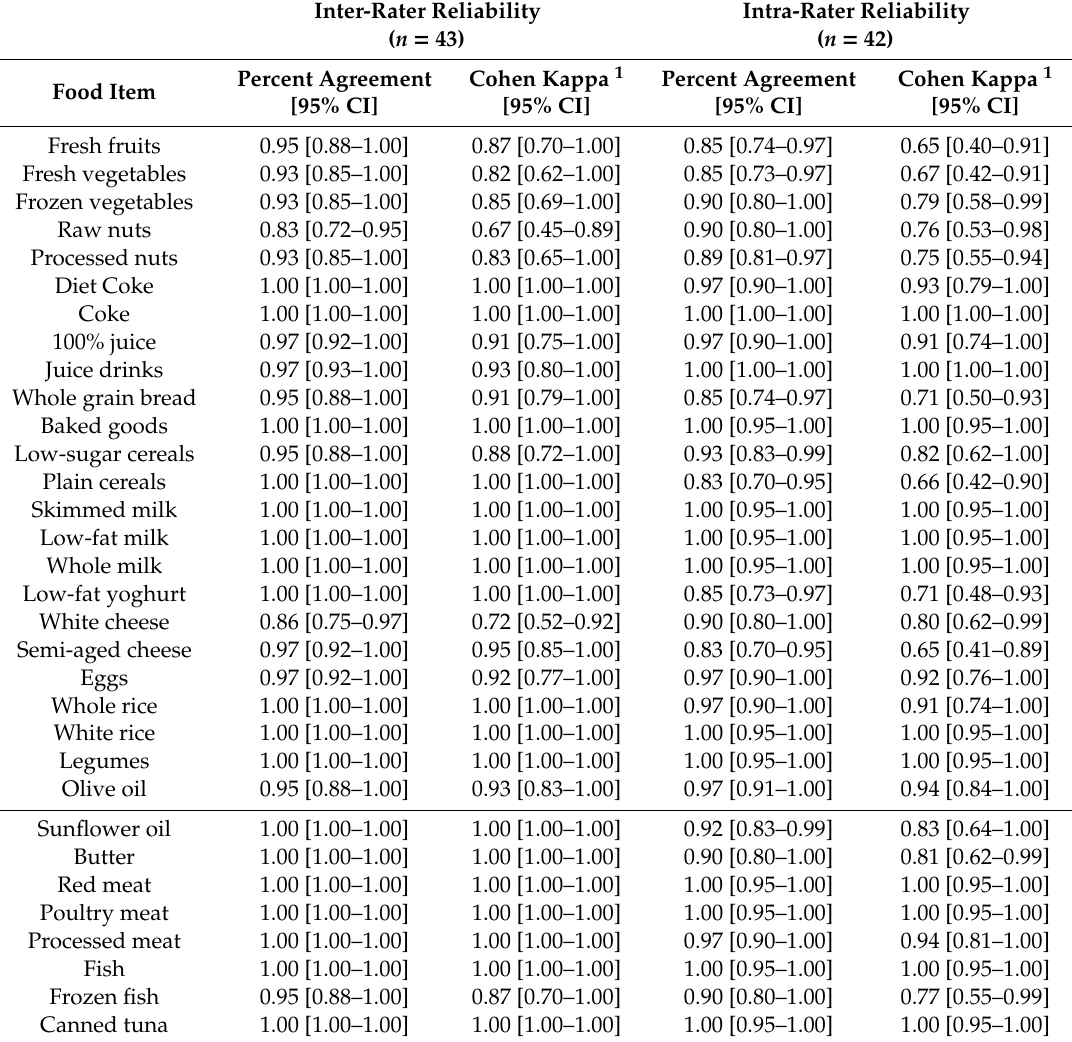
Table 3. Reliability for the availability dimension of the Nutrition Environment Measures Survey in stores for Mediterranean contexts (NEMS-S-MED).